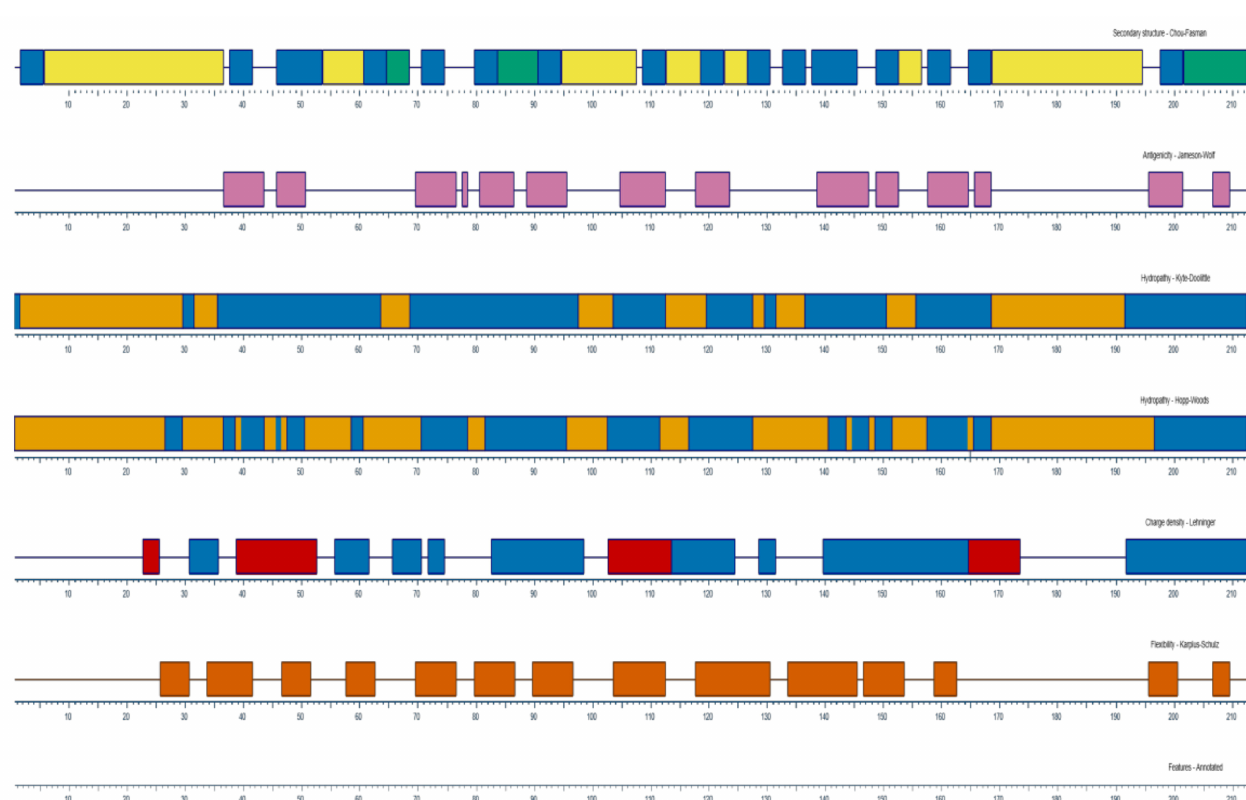
Figure 2. The characteristics of CD8 β molecules analyzed from DNAStar Protean program. The secondary structure, antigenicity, hydrophobicity, charge density and flexibility were represented. Pink, High antigenicity; Blue, Hydrophilic region; Orange, Hydrophobic